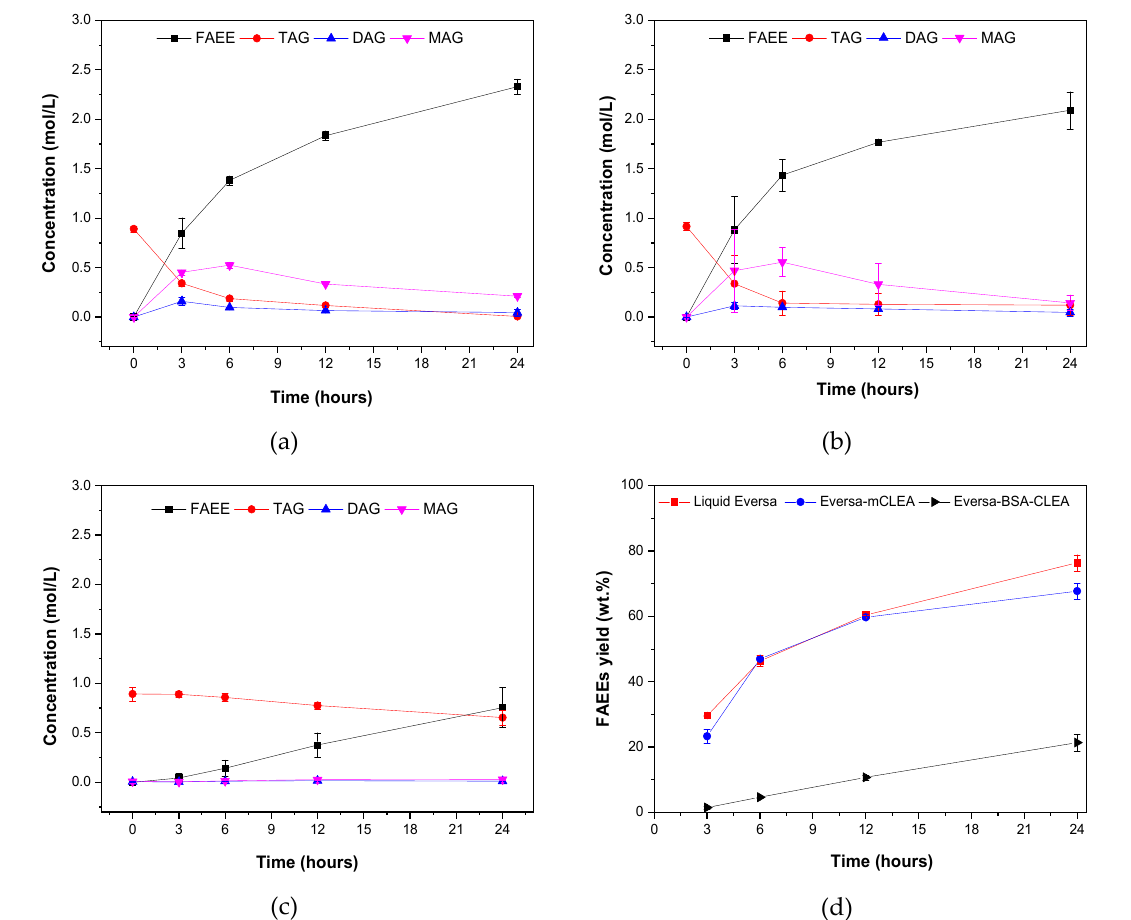
Figure 7. Profiles of molar concentration of fatty acid ethyl esters (FAEEs), triglycerides (TAGs), diglycerides (DAGs), and monoglycerides (MAGs) determined by High Performance Liquid Chromatography with an Ultraviolet Detector (HPLC-UV) (Section 3.9) for the transesterification of soybean oil with ethanol catalyzed by ( a ) liquid Eversa, ( b ) Eversa-mCLEA, and ( c ) Eversa-BSA-CLEA. ( d ) Profiles of FAEEs yield (wt%) determined by Gas Chromatography with a Flame Ionization Detector (GC-FID) (Section 3.10). Reaction conditions: 15 g soybean oil, oil:ethanol molar ratio of 1:6, 3 U est / g oil, 5% (w / w oil ) water, 35 ◦ C, and 1500 rpm stirring in a vortex flow reactor. The values are expressed as the mean of triplicates ± SD.